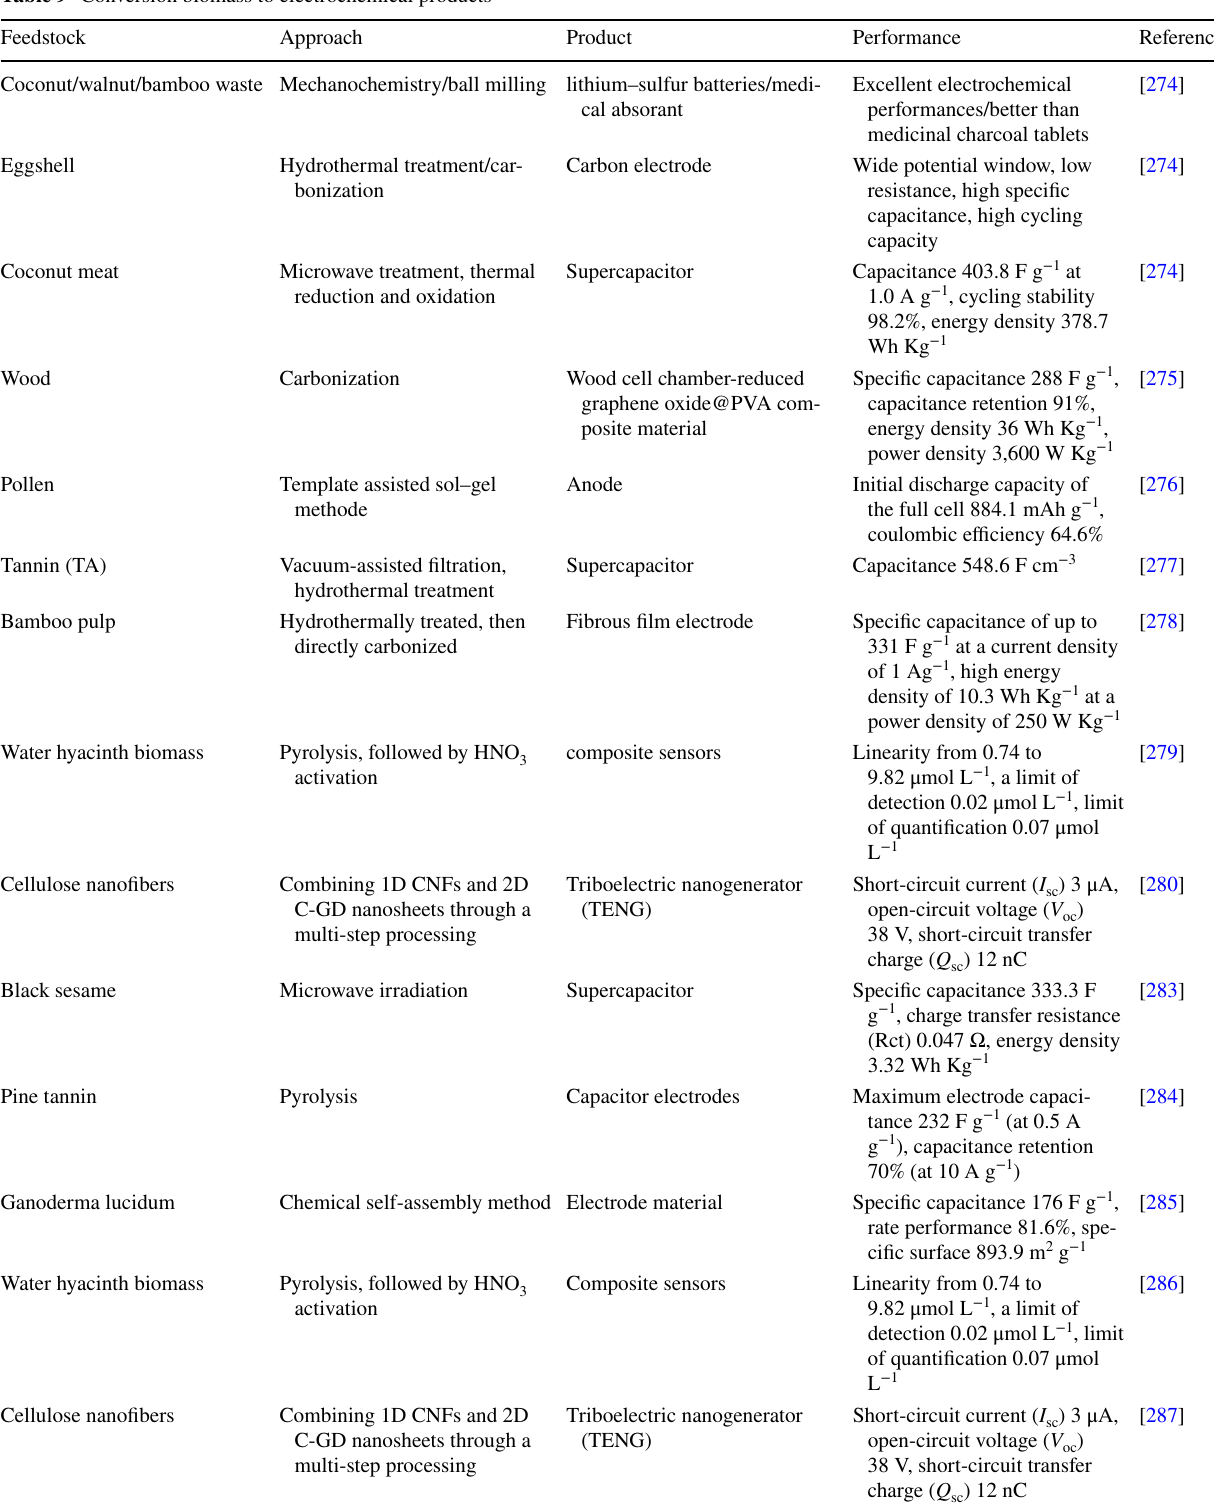
Table 9 Conversion biomass to electrochemical products Feedstock